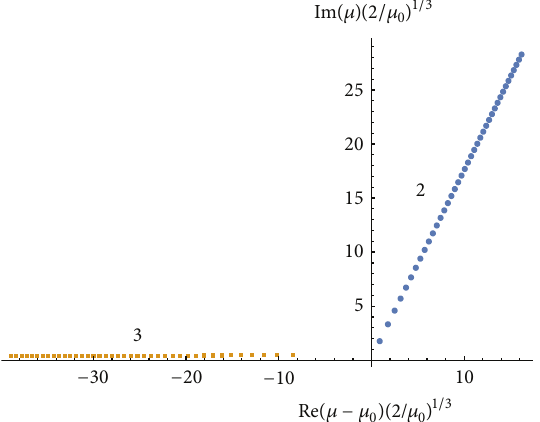
Figure 2: Position of Regge poles for repulsive Fermi-potential. Shown are the poles, corresponding to near-surface states. 2: surface waves and 3: narrow over-barrier